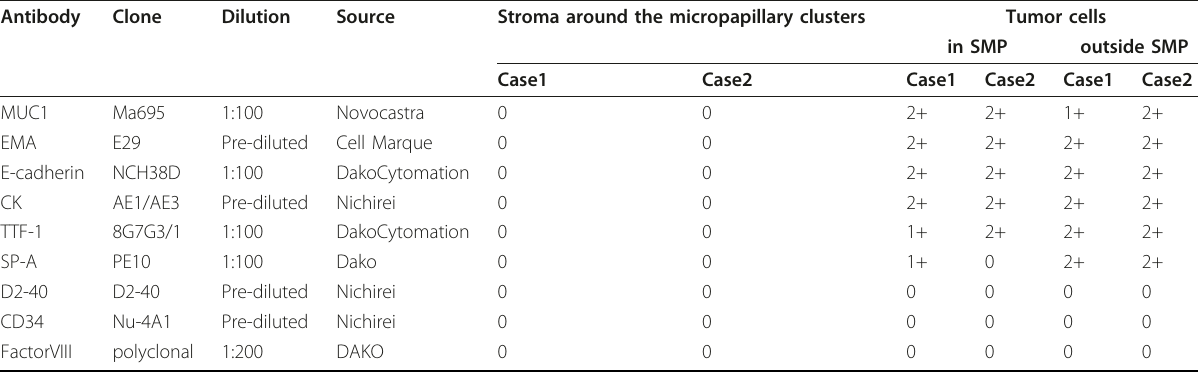
Table 1 Antibodies used and immunohistchemical result Antibody